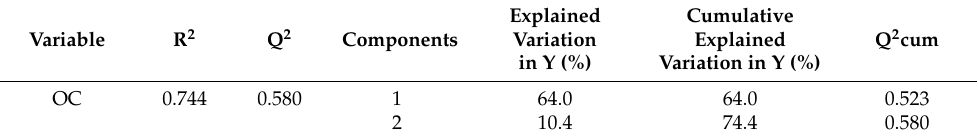
Table 1. Summary of PLSR model outputs relating to soil organic carbon (OC) content in reclaimed area.